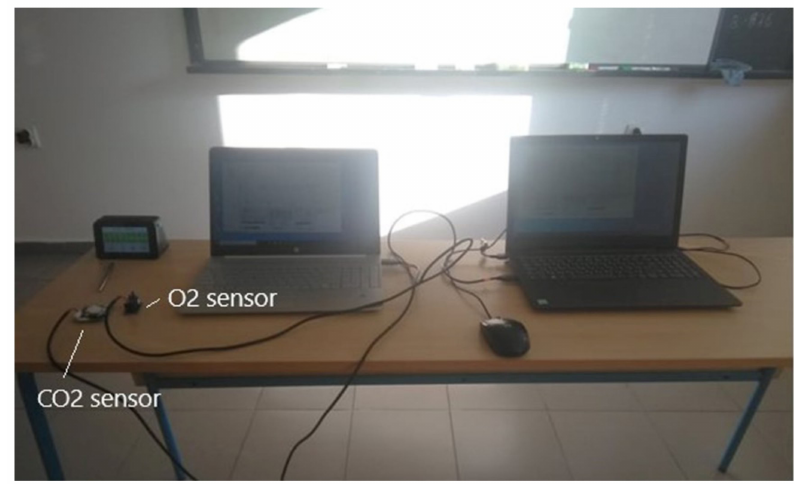
Figure 9. Measuring instruments in the case study